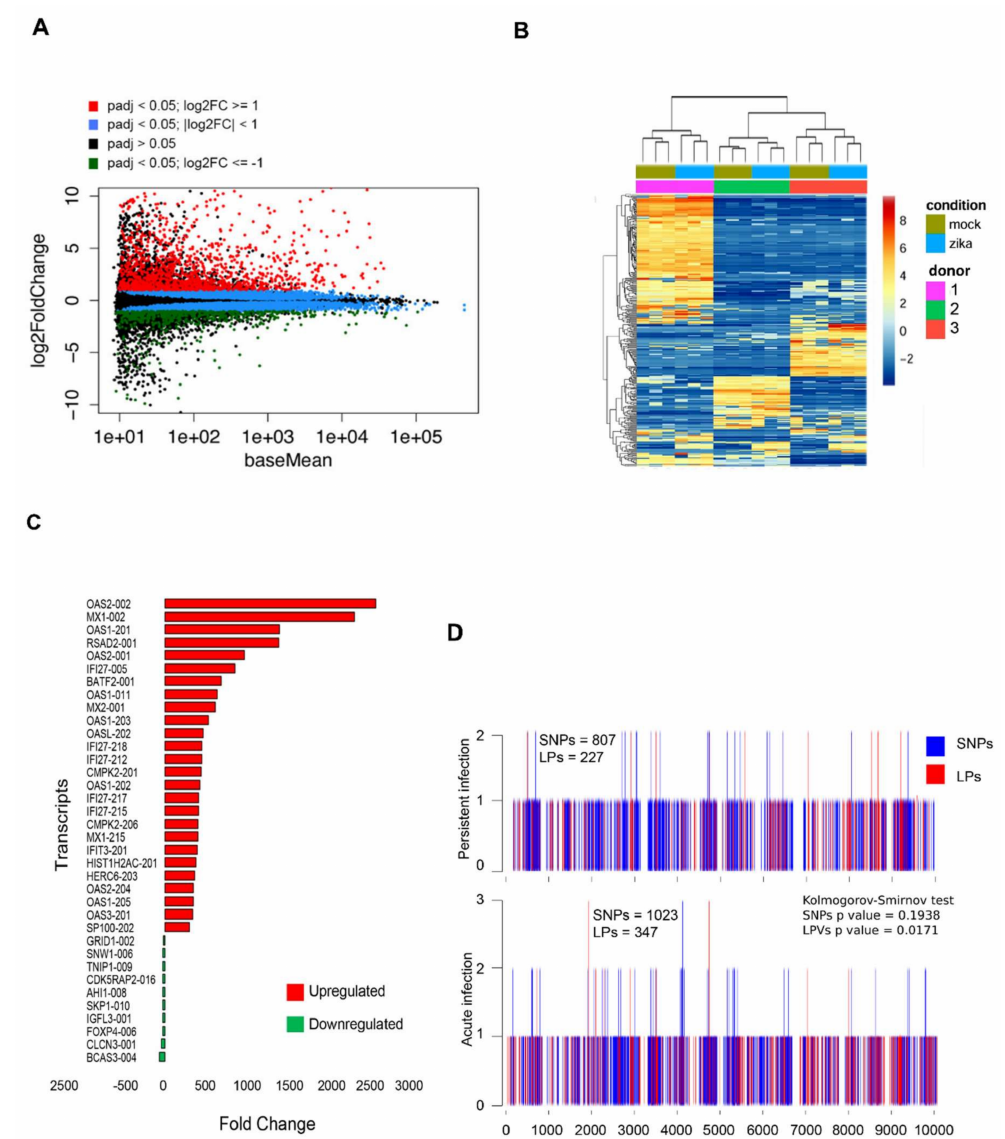
Figure 5. ( A ) Analysis of transcripts differentially expressed in HFAs persistently infected (28 days) with ZIKV. MA plots representing transcripts that were deregulated in cells persistently infected with ZIKV are shown. Red dots represent transcripts that were significantly upregulated with a fold change >2; green dots represent transcripts that were significantly downregulated with a fold change <–2; blue dots represent genes that were significantly deregulated with a fold change <2; black dots represent genes not differentially expressed. ( B ) Hierarchical clustering identified two major clusters of differentially expressed genes in persistently infected HFAs (28 days), with relatively consistent expression across samples (i.e., consistently up or downregulated in ZIKV-infected or mock samples). Z -scores of 400 differentially expressed genes exhibiting the largest variance between mock and ZIKV-infected samples are plotted. ( C ) The fold-change and the corrected P value of the top up- and downregulated transcripts are presented for persistently infected HFAs (28 days). ( D ) Mutations are not accumulated in the ZIKV genome after persistent infection. Single nucleotide polymorphisms (SNPs) and length polymorphisms (LPs) were determined in the ZIKV genome in acute (2 days) and persistent (28 days) infection of HFAs using the software Vphaser-2. Kolmogorov–Smirnov test was applied on the frequency of each type of mutations consolidated in segments of 500